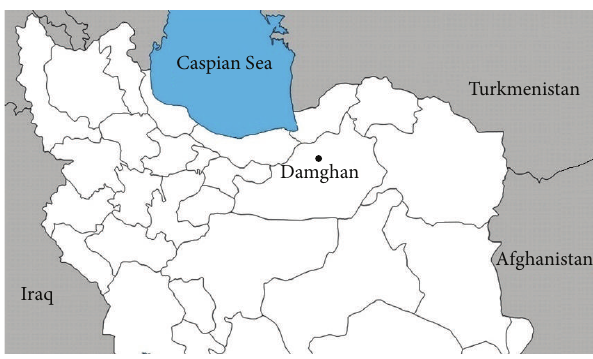
Figure 1: Map showing the sampling site (Damghan County) in northern